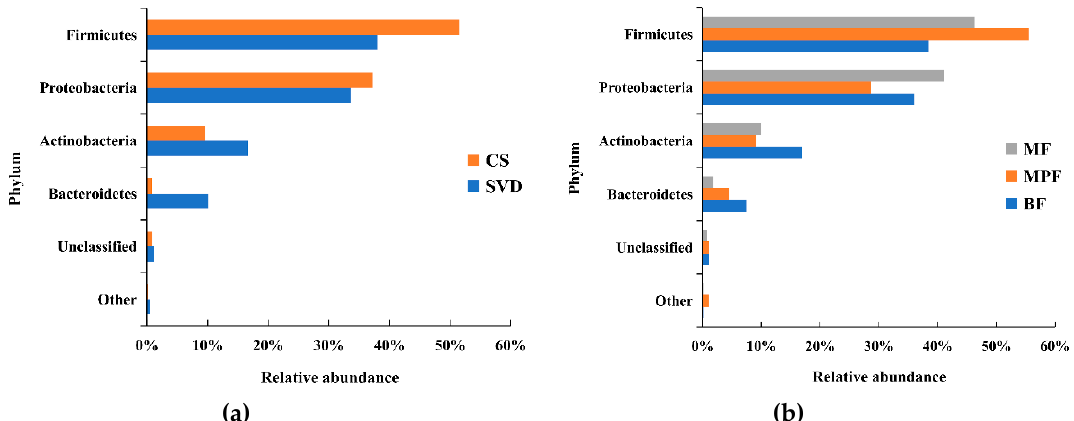
Figure 1. Composition of infant gut microbiota at the phylum level in different delivery modes and feeding methods. ( a ) Delivery modes; ( b ) Feeding methods. Showing phyla found at > 1% average in total population. Phyla found at < 1% were grouped as “other”. BF: breast-fed; CS: caesarean section; MF: mixed-fed; MPF: milk-powder-fed; SVD: standard vaginally delivered.